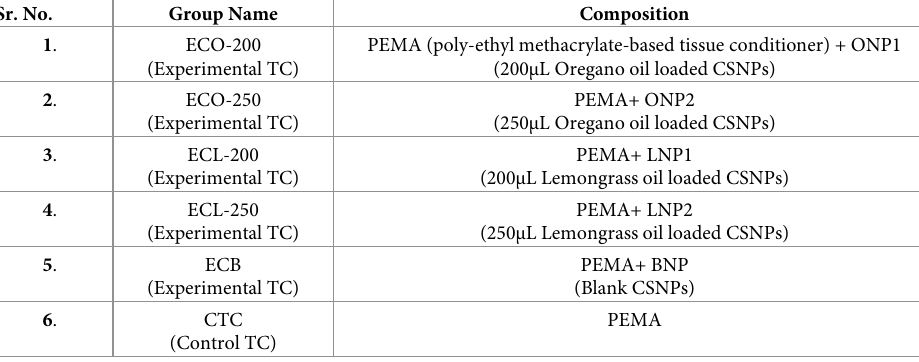
Table 1. Groups of tissue conditioners used in the experiment (n = 3). Sr.